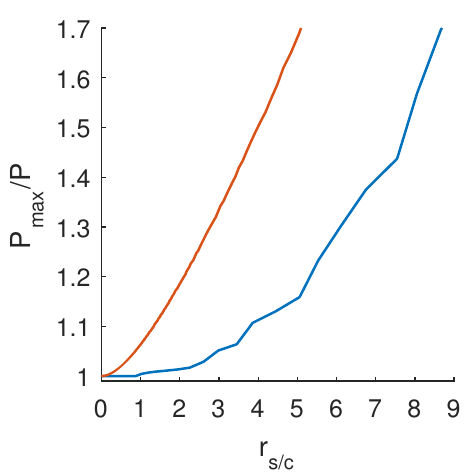
Figure 6. Fuel cell oversize for minimum fuel cell system weight as function of the ratio of tank-to-fuel cell mass. Red: Stationary tank design. Blue: Advanced tank design of Winnefeld et al.